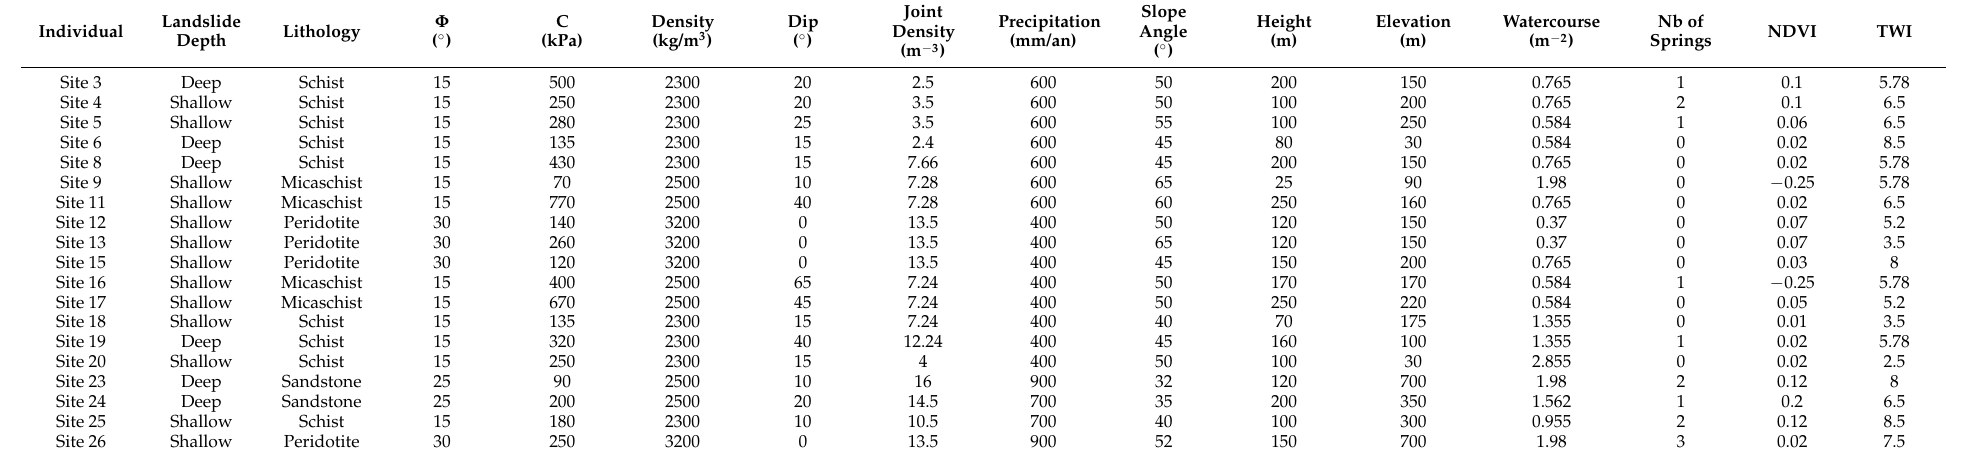
Table A2. PCA landslide input data. See explanation of the abbreviations in Table 2.